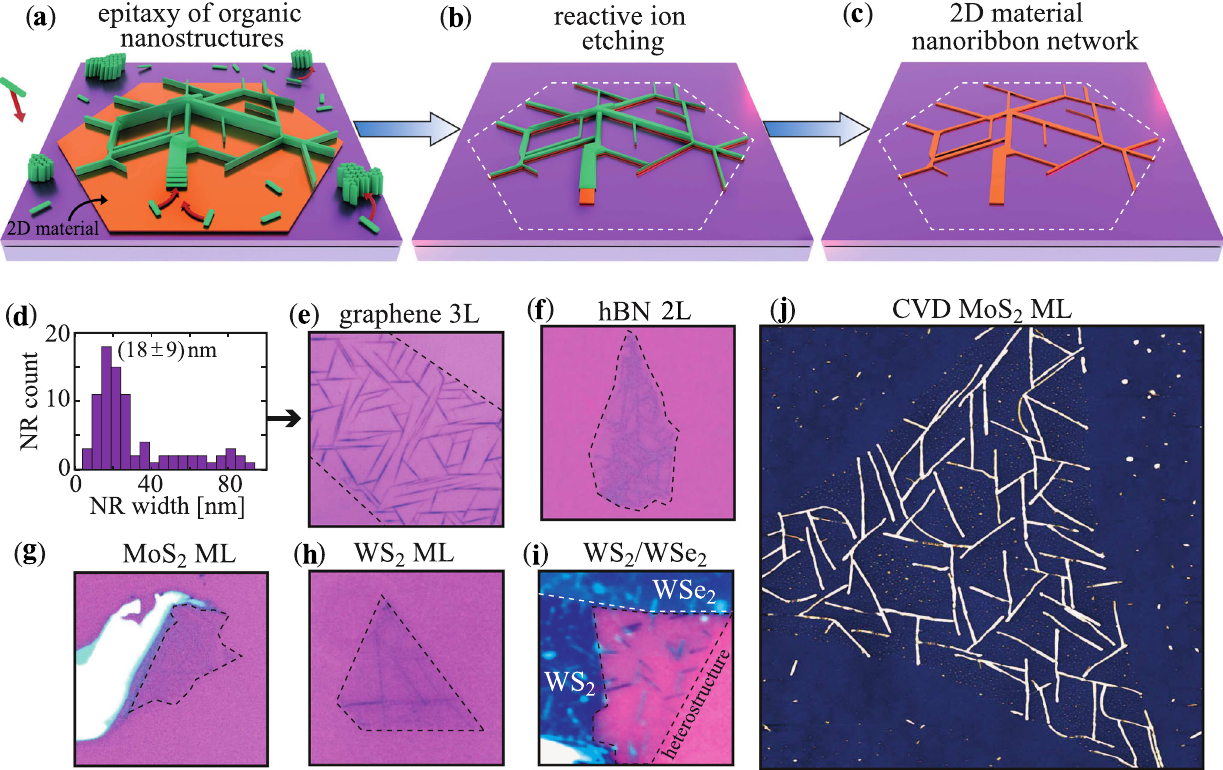
Fig. 1 Fabrication of 2D material NRNs. a – c Schematic representation of the key fabrication steps. a Organic nanostructures self-assembly and self-alignment. b After reactive ion etching. c NRN after removal of the sacri fi cial organic layer. d Histogram of NR widths for a graphene NRN shown in e . e – i Optical micrographs of various 2D material NRNs, presenting respectively NRNs of graphene, hBN, MoS 2 , WS 2 , and WS2/WSe2 heterostructure. j AFM topography image of a NRN from chemical vaopour deposition (CVD) Monolayer(ML) MoS 2 (22 × 22 μ m 2 , z -scale 15